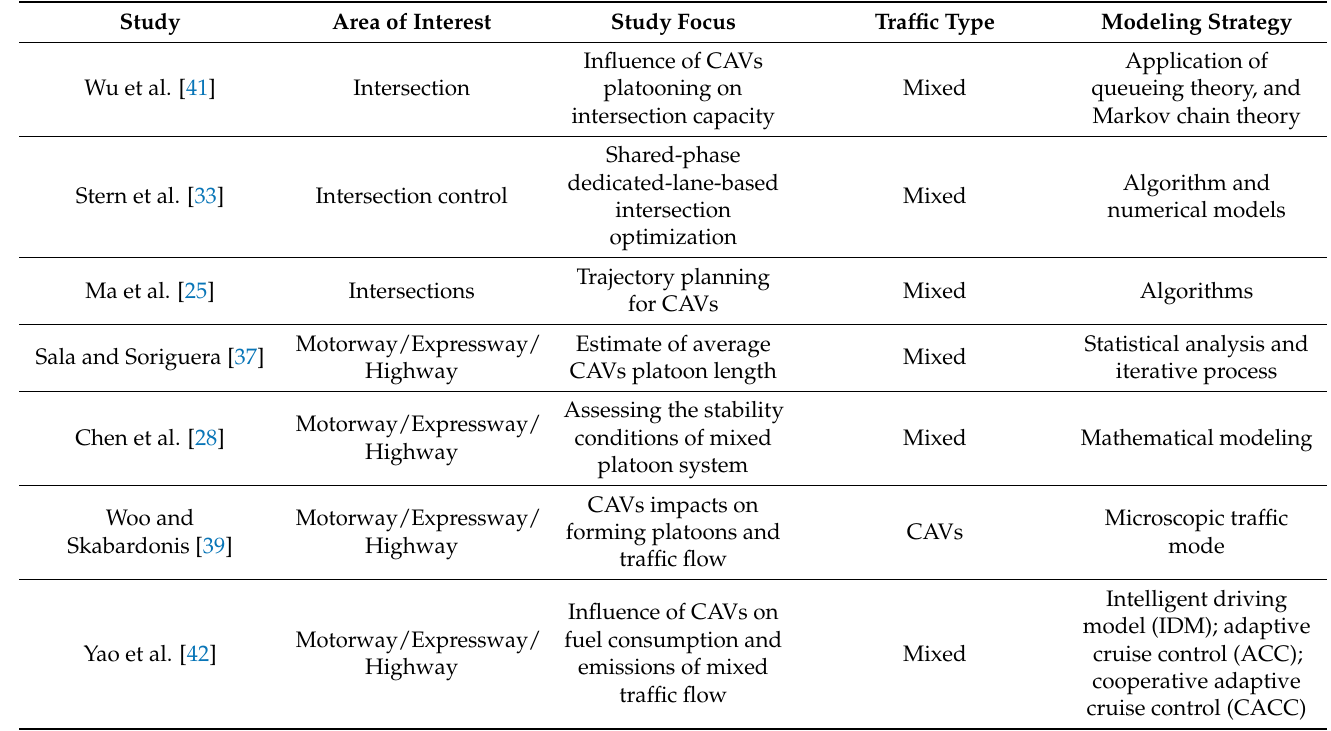
Table 2. Studies on network performance in the presence of